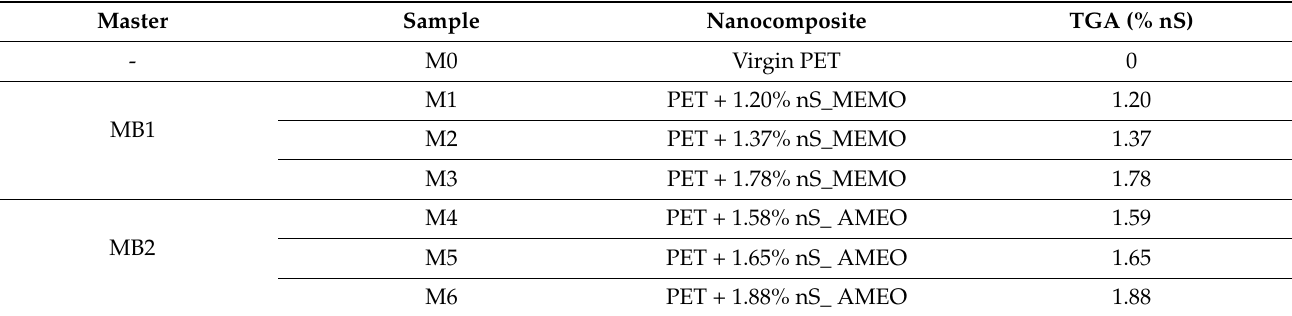
Table 1. Samples and sepiolite content on the